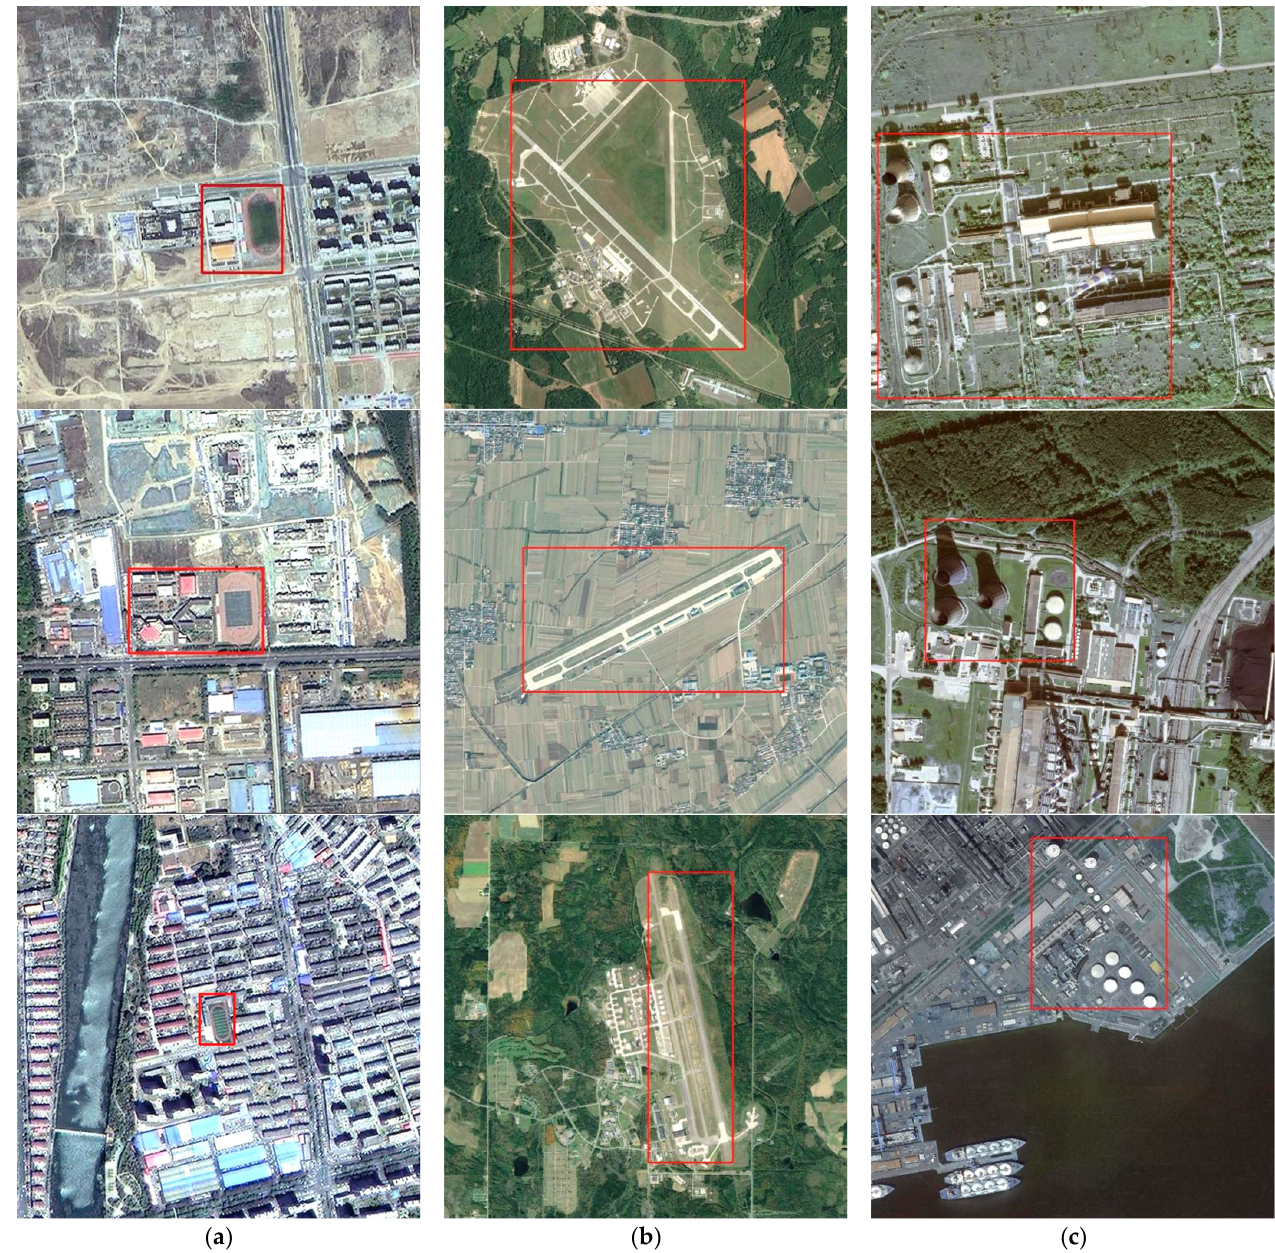
Figure 1. Samples of composite objects: ( a ) primary and secondary schools at different scales; ( b ) airports in DIOR datasets; ( c ) thermal power plants in AIR-TPPDD [14].